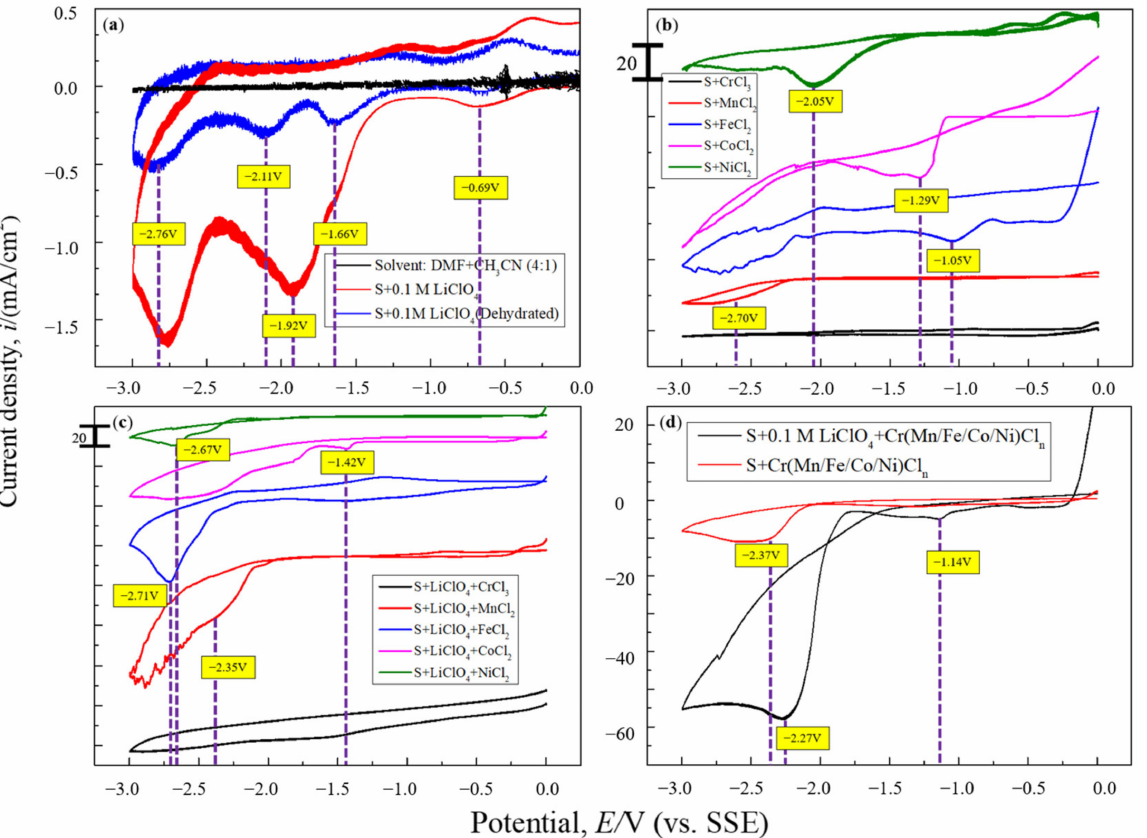
Figure 1. Cyclic voltammetry curves obtained on a Cu disk ( Φ : 1 mm) in DMF-CH 3 CN (4:1 by volume) solution at a sweep rate of 100 mV/s. ( a ) Without and with 0.1 M LiClO 4 ; ( b ) Containing isolated 0.01 M FeCl 2 , CoCl 2 or 0.02 M CrCl 3 , MnCl 2 , NiCl 2 without LiClO 4 ; ( c ) Containing isolated 0.01 M FeCl 2 , CoCl 2 or 0.02 M CrCl 3 , MnCl 2 , NiCl 2 with 0.1 M LiClO 4 ; ( d ) Containing 0.01 M CrCl 3 , 0.01 M MnCl 2 , 0.01 M FeCl 2 , 0.01 M CoCl 2 , and 0.01 M NiCl 2 with and without 0.1 M LiClO 4